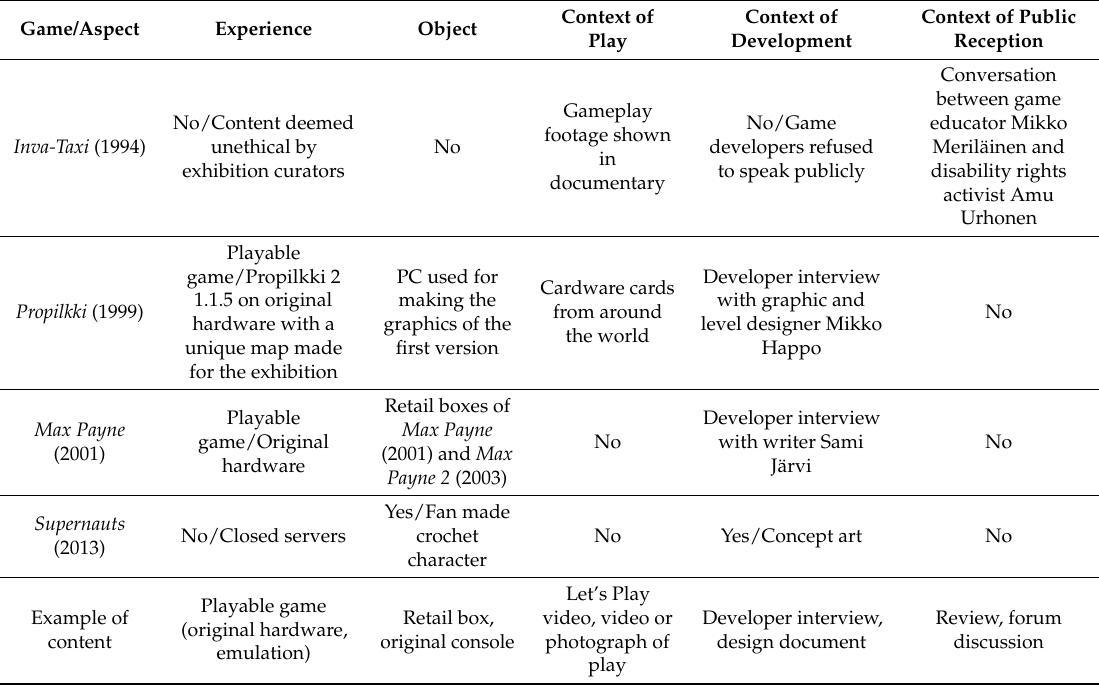
Table 1. Aspects of digital games in